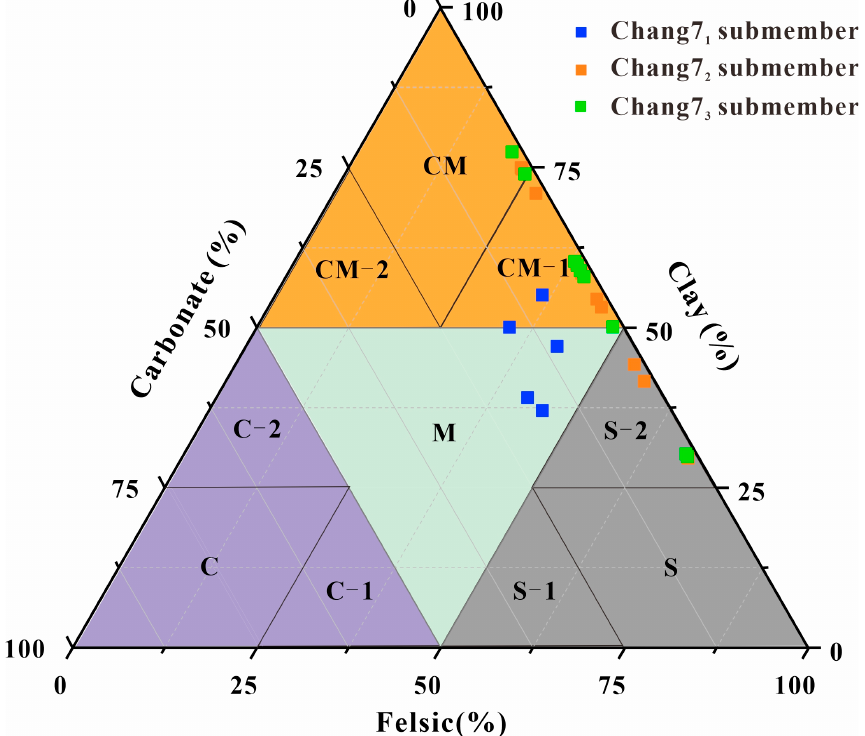
Figure 4. Three-terminal element diagram of shale mineral composition. For the siltstone